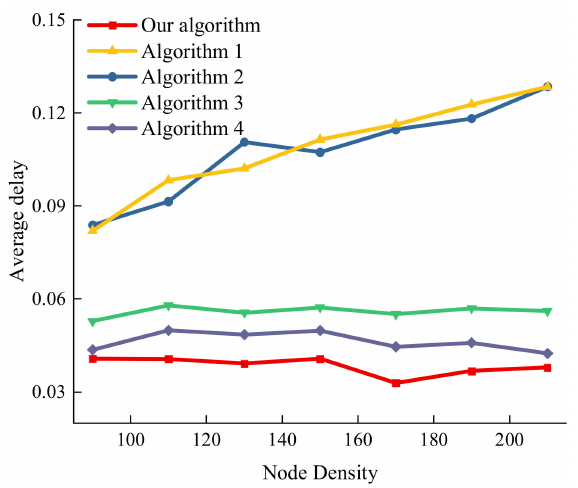
Figure 8. End-to-end average delay with a different number of